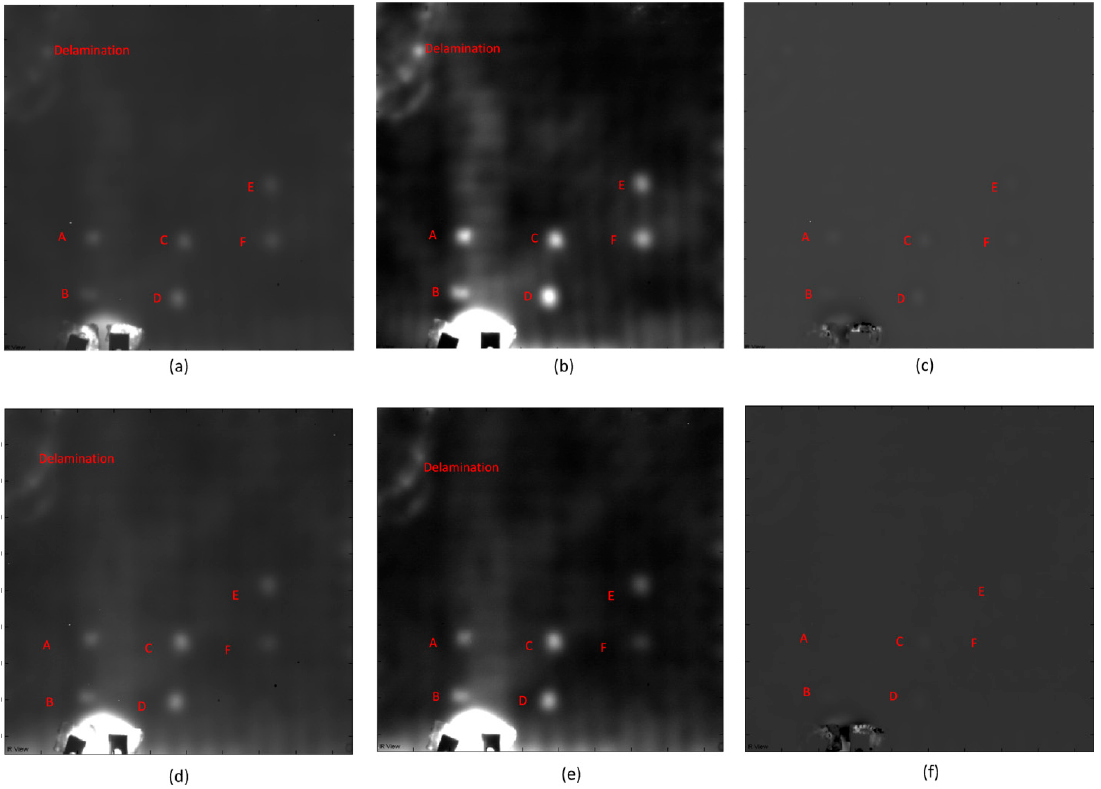
Figure 7: The vibrothermography results, (a) 50% power: raw image, (b) 50% power: CIS, (c) 50% power: PCT, (d) 80% Figure 7. The vibrothermography results: ( a ) 50% power: raw image; ( b ) 50% power: CIS; ( c ) 50% power: raw image, (e) 80% power: CIS, (f) 80% power: PCT. power: PCT; ( d ) 80% power: raw image; ( e ) 80% power: CIS; ( f ) 80% power: